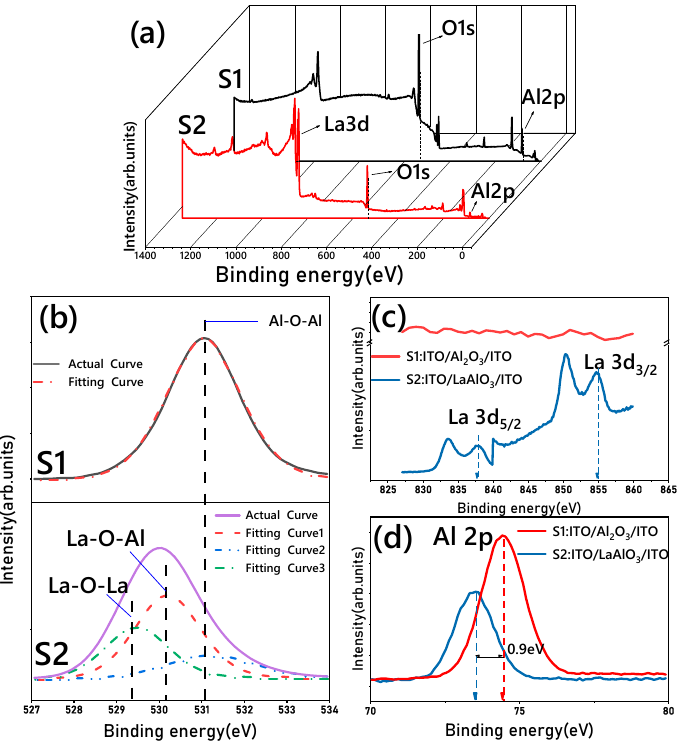
Figure 2. ( a ) Full spectrum of XPS test; ( b ) The 1s peak spectrum of O element; ( c ) The 3d peak spectra of the La element; ( d ) 2p peak spectrum of Al